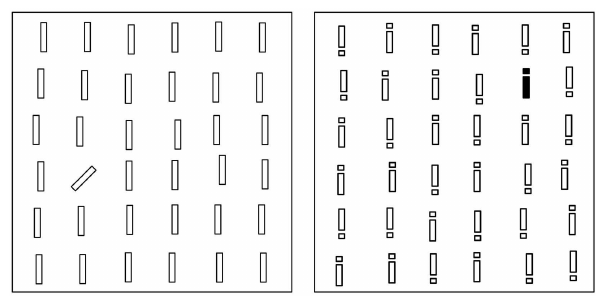
FIGURE 2 | Examples of search displays used in the empirical studies discussed in the present review. Left-hand panel: Singleton feature search.The target item differs from the distractors by its color or orientation (shown) in non-redundant target trials or by color and orientation in redundant target trials; distractors all have the same color and orientation. Right-hand panel: Compound search task.The to-be-detected target differs from distractors by its color (shown) or orientation; the response is defined by the position of the gap cut into the target item at the top or bottom part. Distractors all have the same color and orientation. Cuts are located in the upper and lower parts, respectively, in half the items. Spatial locations of all the search items are randomly shifted relative to center of the cell of a virtual grid underlying the spatial arrangement of the search display. Note that the number and spatial arrangement of the display items varied according to the research issue under investigation. Note that the present example displays are not drawn to